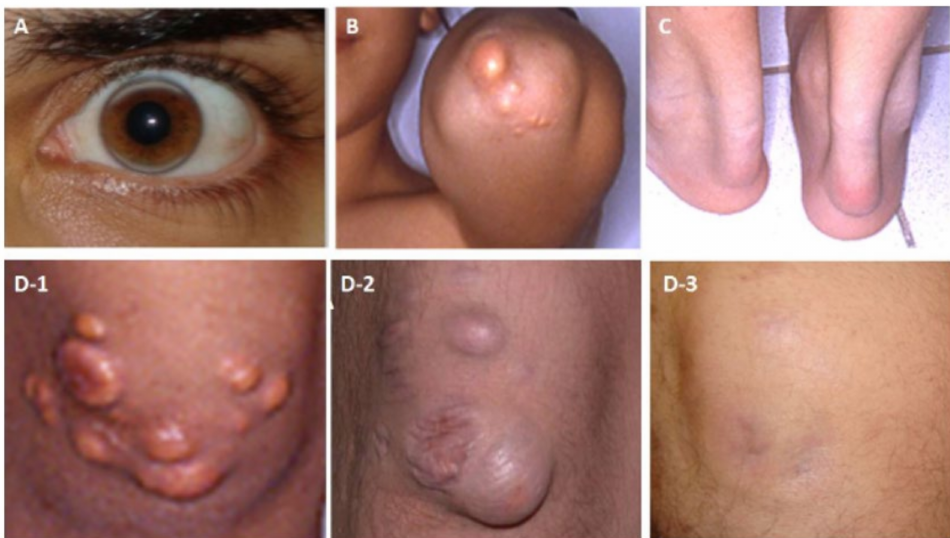
Figure 2. Examples for cholesterol depositions of a patient with HoFH ( A ) Arcus lipemia (at age 23 years, while on a regular apheresis treatment for 3 years), ( B ) Cholesterol deposition on the extensor surface of the elbow (at age 13), ( C ) Thickening of the Achilles tendon due to cholesterol deposition (at 13 years of age) ( D1–3 ) Deposition in the skin on the extensor surface of the knee-joint ( D-1 ) Before apheresis at 13 years of age, ( D-2 ) After a 3-year discontinuation of apheresis at 21 years of age, and ( D-3 ) Cholesterol deposition on the extensor surface of the knee-joint disappearing